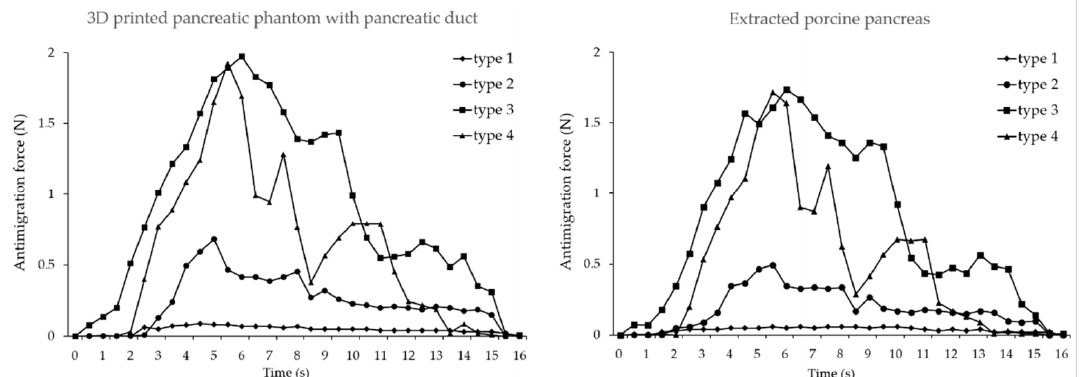
Figure 5. Continuous antimigration force (AMF) changes according to the times in the 3D-printed pancreatic phantom with the pancreatic duct and the extracted porcine pancreas.